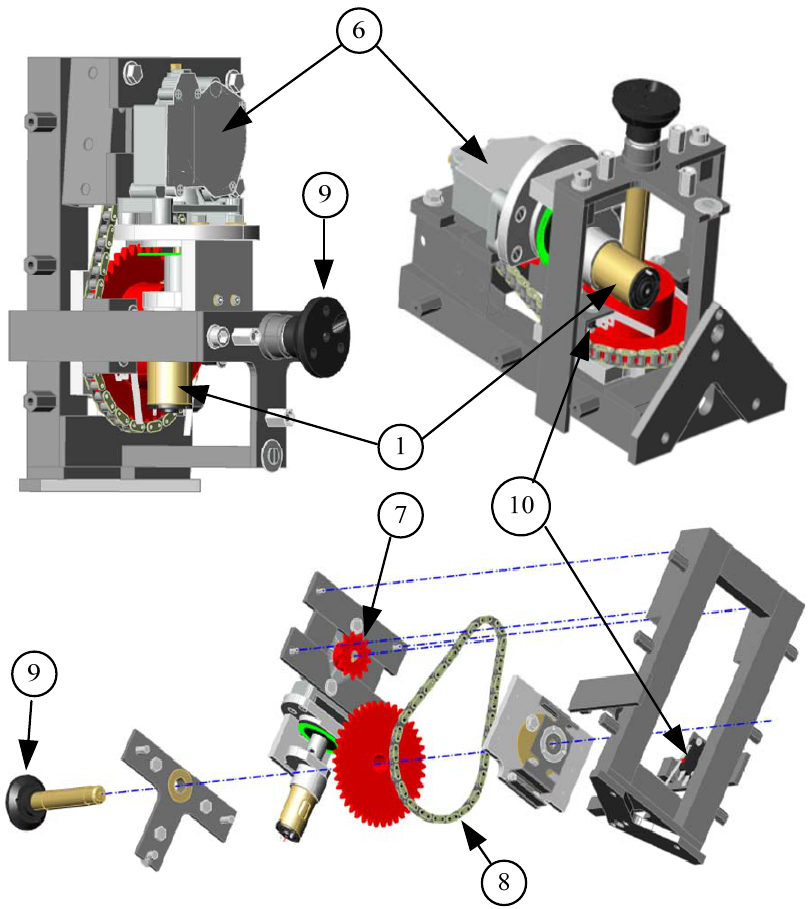
Figure 5. 3D picture of the servomotor module and the clamp-moving